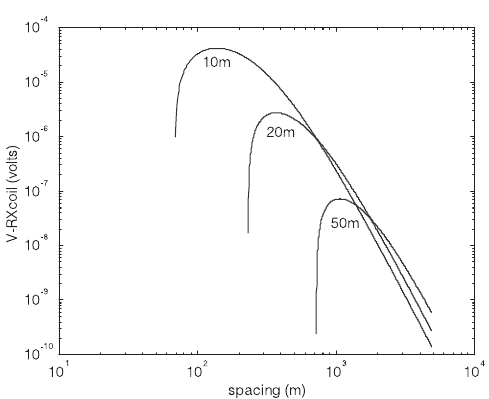
Fig. 5. Voltage response at the receiver for different target depth and fixed time window = 0.01 ms.